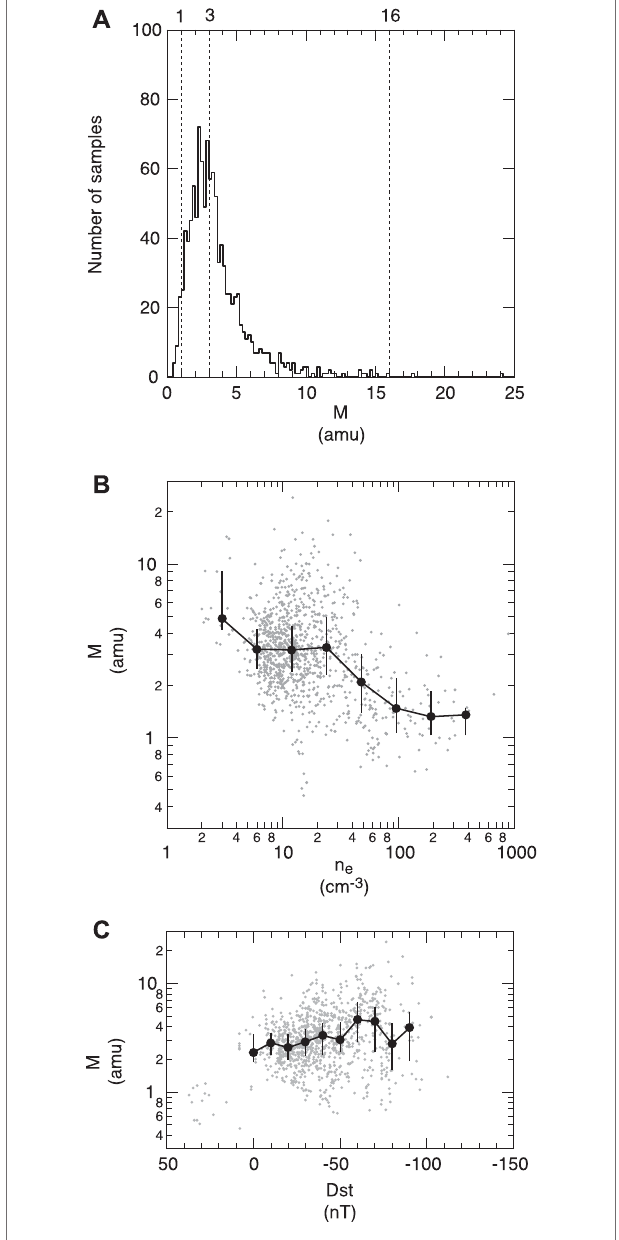
FIGURE 5 | Statistical properties of the average ion mass ( M ) obtained using CRRES data and assuming α (cid:1) 0.5 (after Takahashi et al., 2006). (A) Occurrence distribution. (B) . Dependence on electron density n e . The gray dots are individual samples, the fi lled black circles are medians, and the vertical bars connect the upper and lower quartiles. (C) Dependence on